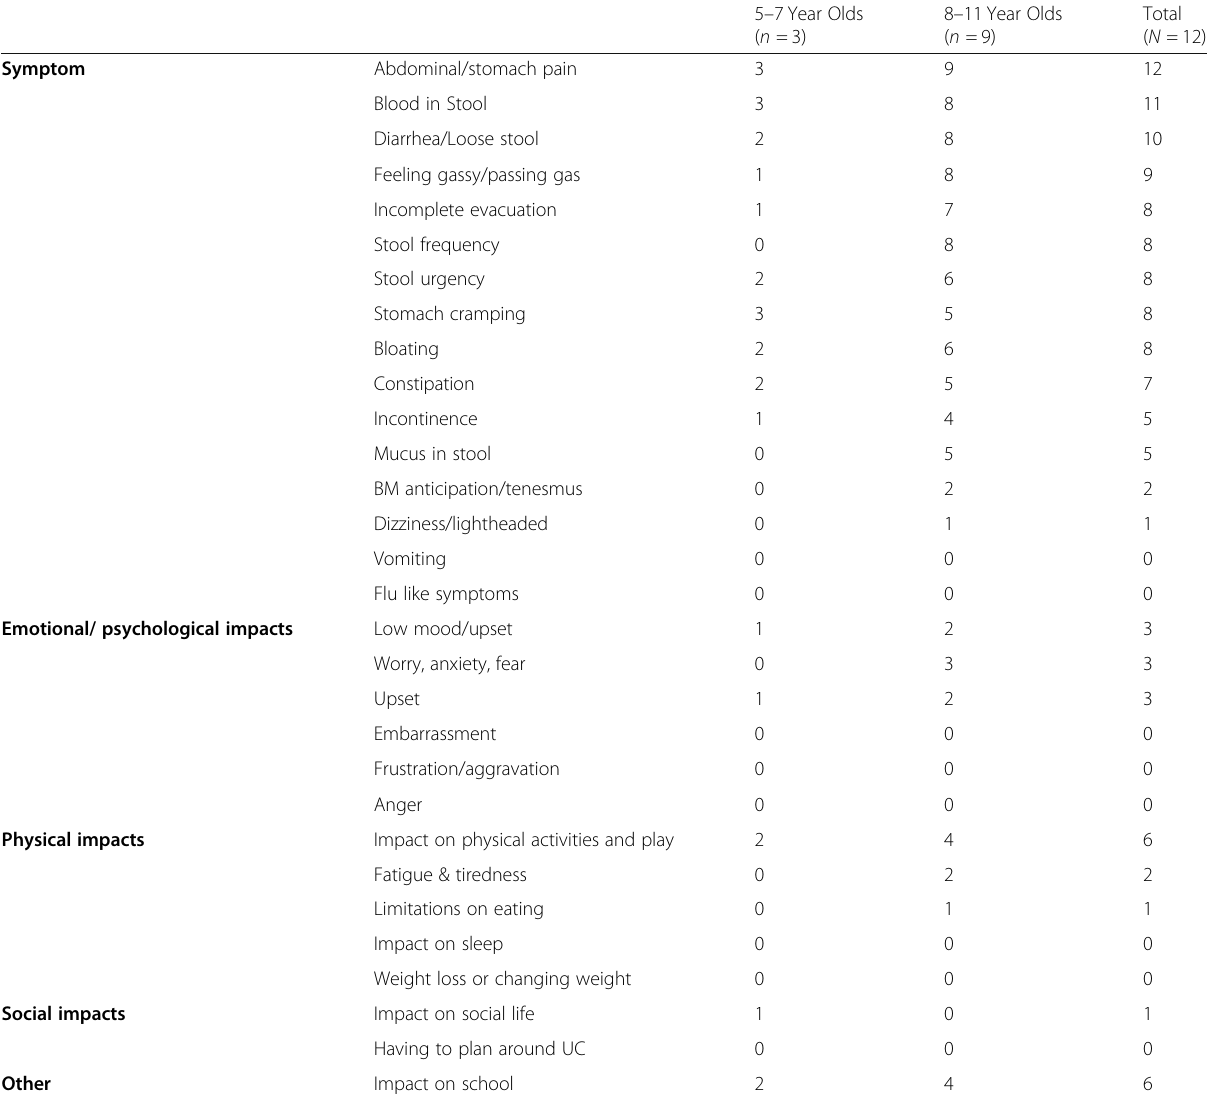
Table 3 Frequency counts for agreement on presence/absence of a symptom/impact by the parent and child during dyad